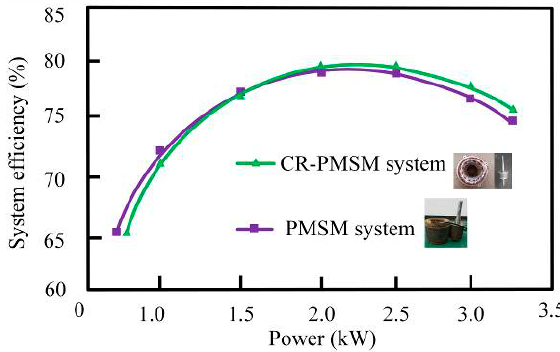
Figure 24. Comparison of system efficiency characteristics under turbine load.